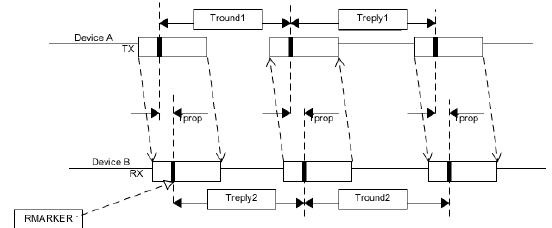
Figure 2. Principle of double-sided two-way ranging with three messages. Where T round 1 = T 4 − T 1 , T round 2 = T 6 − T 3 , T reply 1 = T 3 − T 2 , and T reply 2 = T 5 − T 4 .